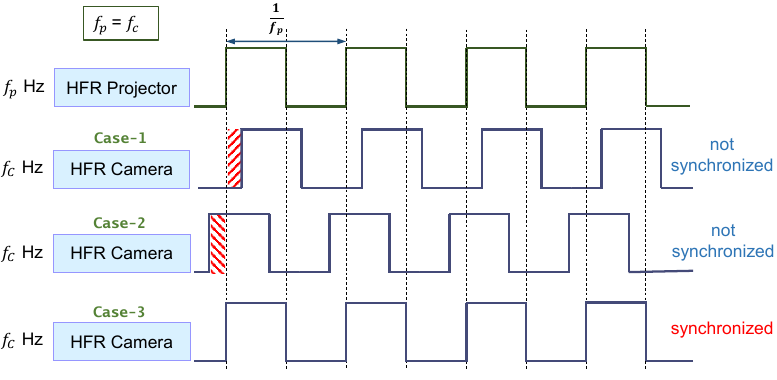
Figure 5. Projector–camera synchronization error.